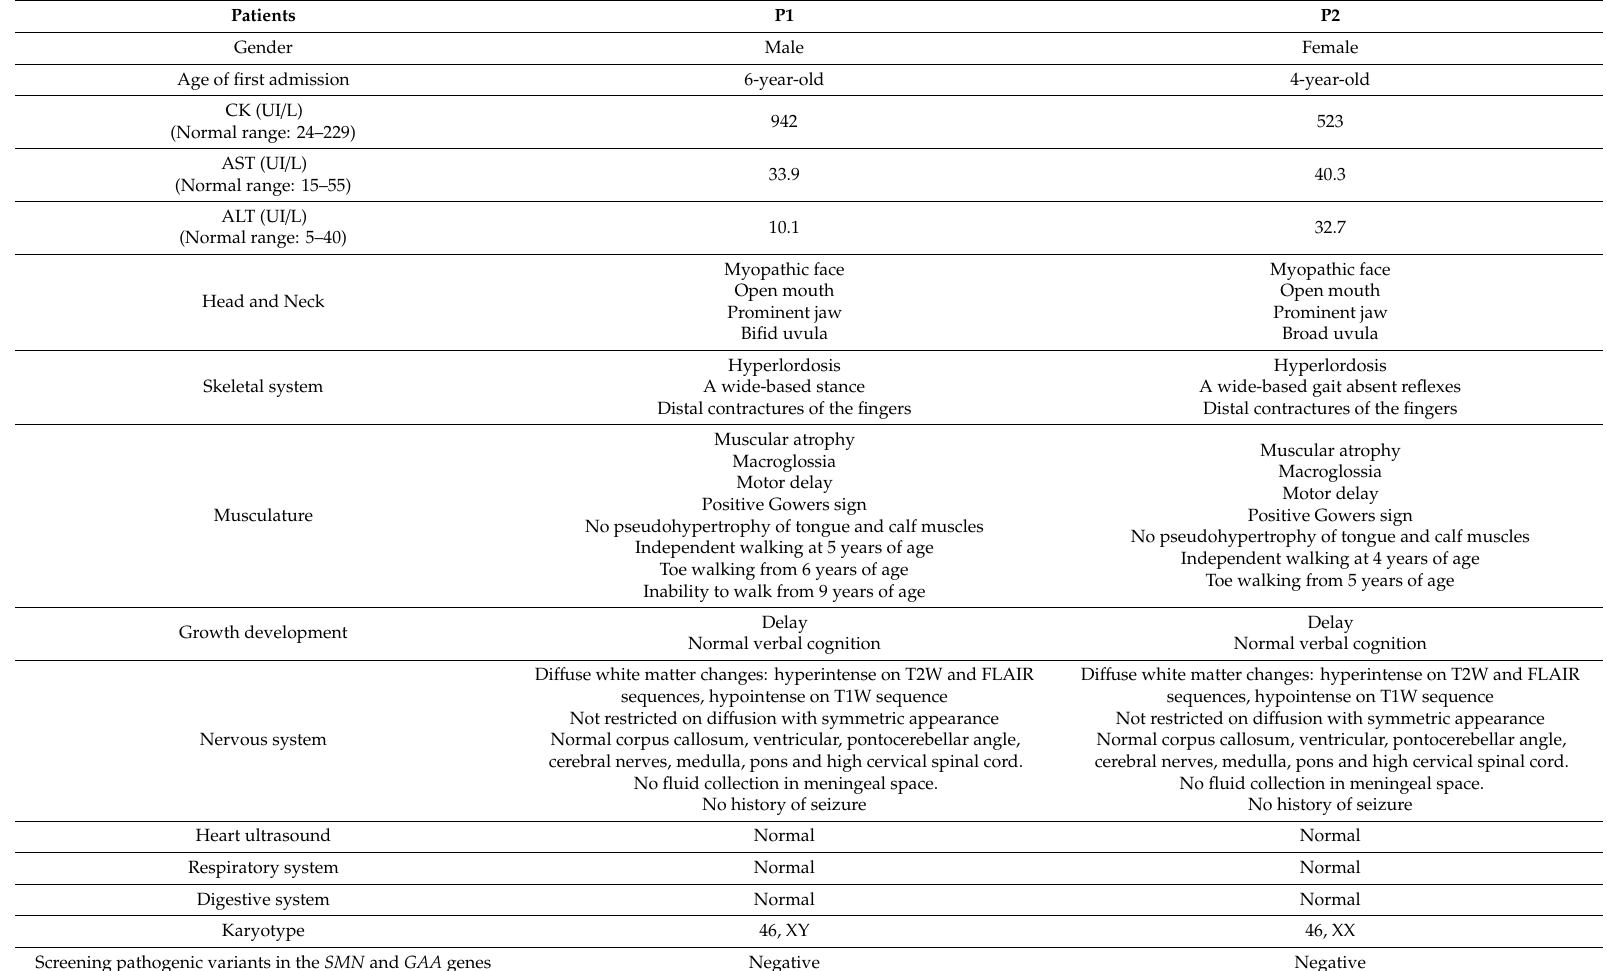
Table 1. Clinical and laboratory data of two